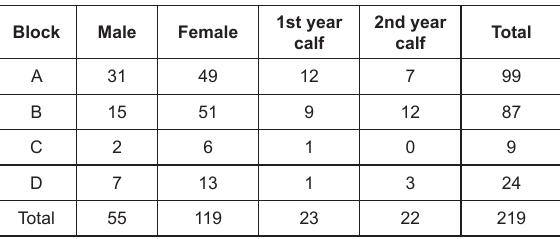
Table 1. Block wise population status of wild buffalo at